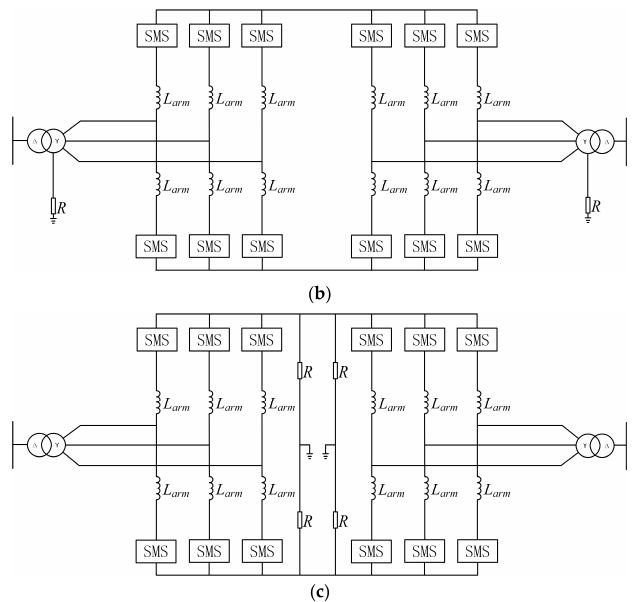
Figure 2. Specific structure of the MMC grounding scheme. ( a ) Through star-connected reactors and a large resistor at AC side; ( b ) Adopting a resistor at the neutral point of AC side transformer; ( c ) Using two large resistors in parallel at the DC side.